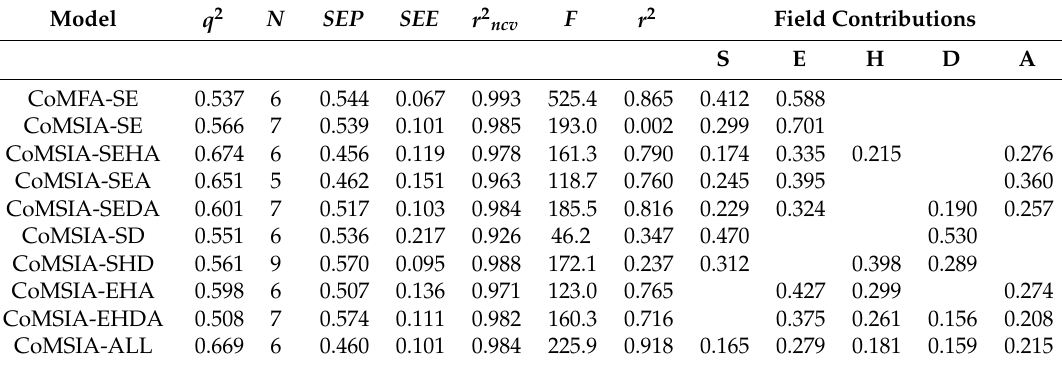
Table 1. Statistical parameters and Field combinations for CoMFA and CoMSIA a